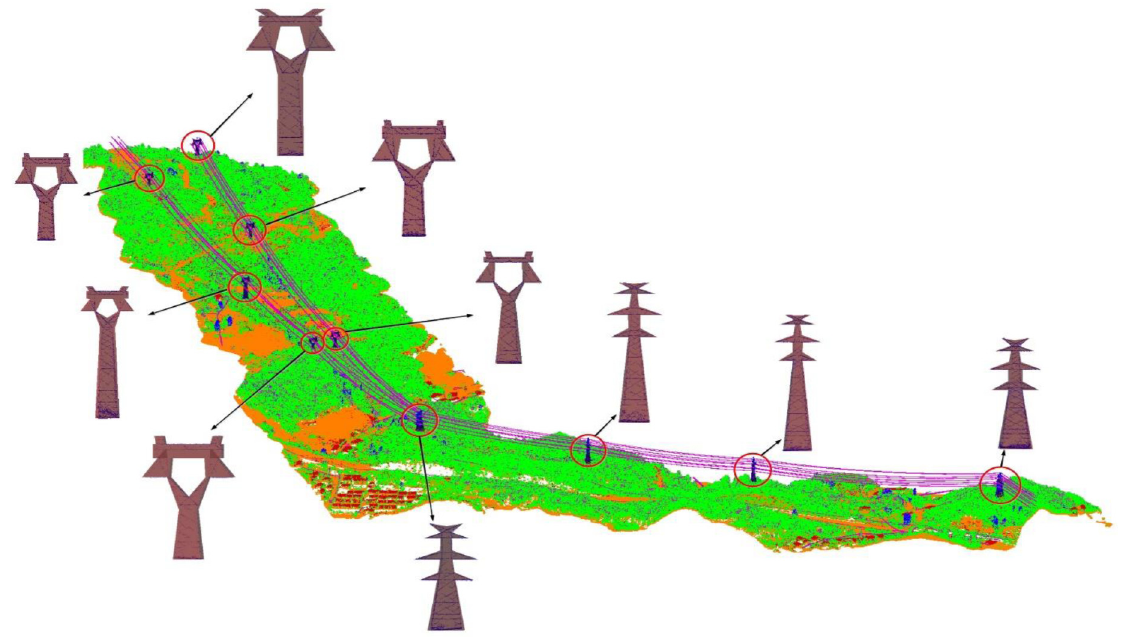
Figure 8. Reconstruction results of Region 1.